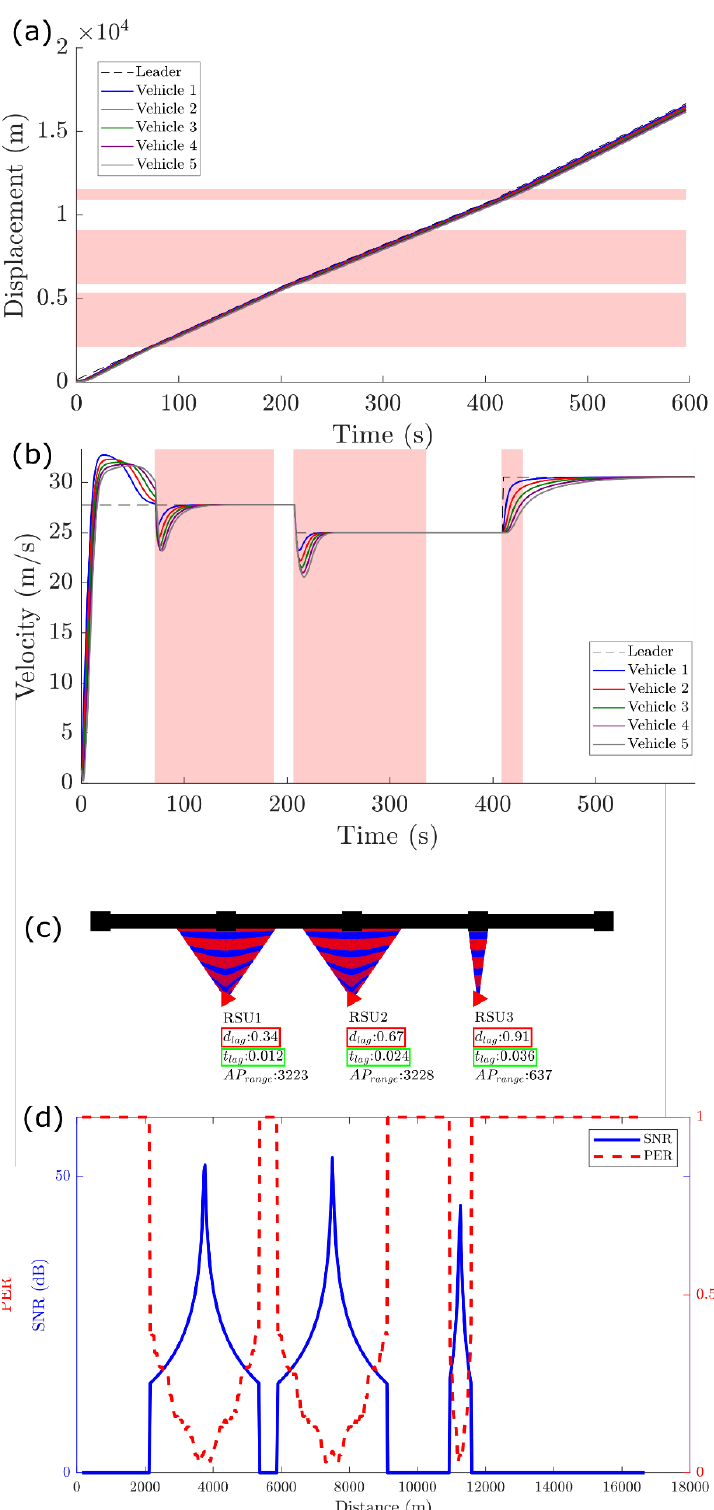
Figure 12. Case VI vehicle platoon motion as described in Section 3.4: ( a ) Displacement of the vehicles over the simulation time; ( b ) Velocity of the vehicles over the simulation time; ( c ) Depiction of the coverage range of RSU’s (red) and the range during which the car communicates with the RSU (blue). The distance lag (red), time lag (green) and the RSU range are also mentioned; ( d ) Variation of SNR and PER as the platoon moves along the road. Leader is the platoon leader.